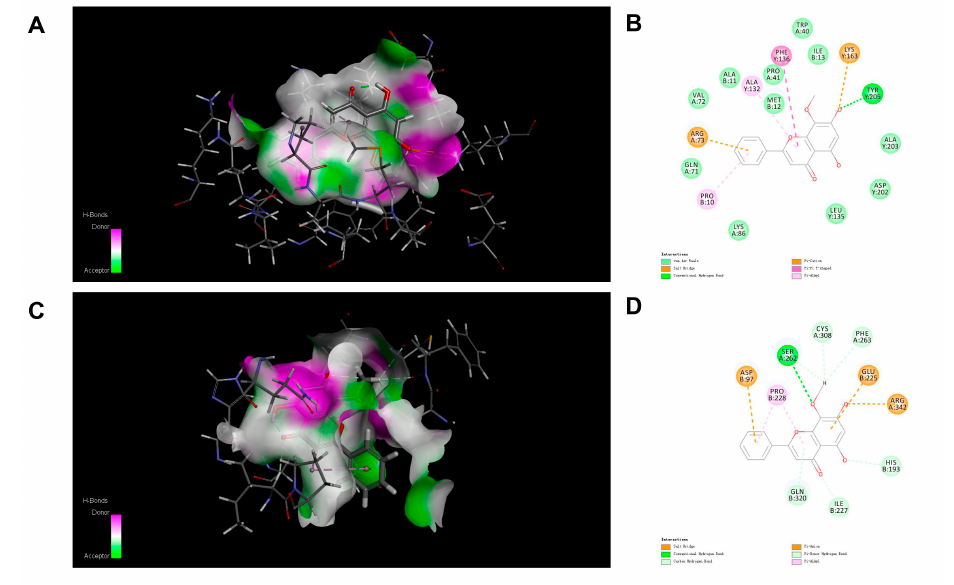
Figure 5. Molecular docking diagram. The 3D ( A ) and 2D ( B ) patterns of PDGFR protein binding with wogonin. The 3D ( C ) and 2D ( D ) patterns of HIF-1 α protein binding with wogonin. Table 1. Molecular docking analysis of wogonin at active sites.